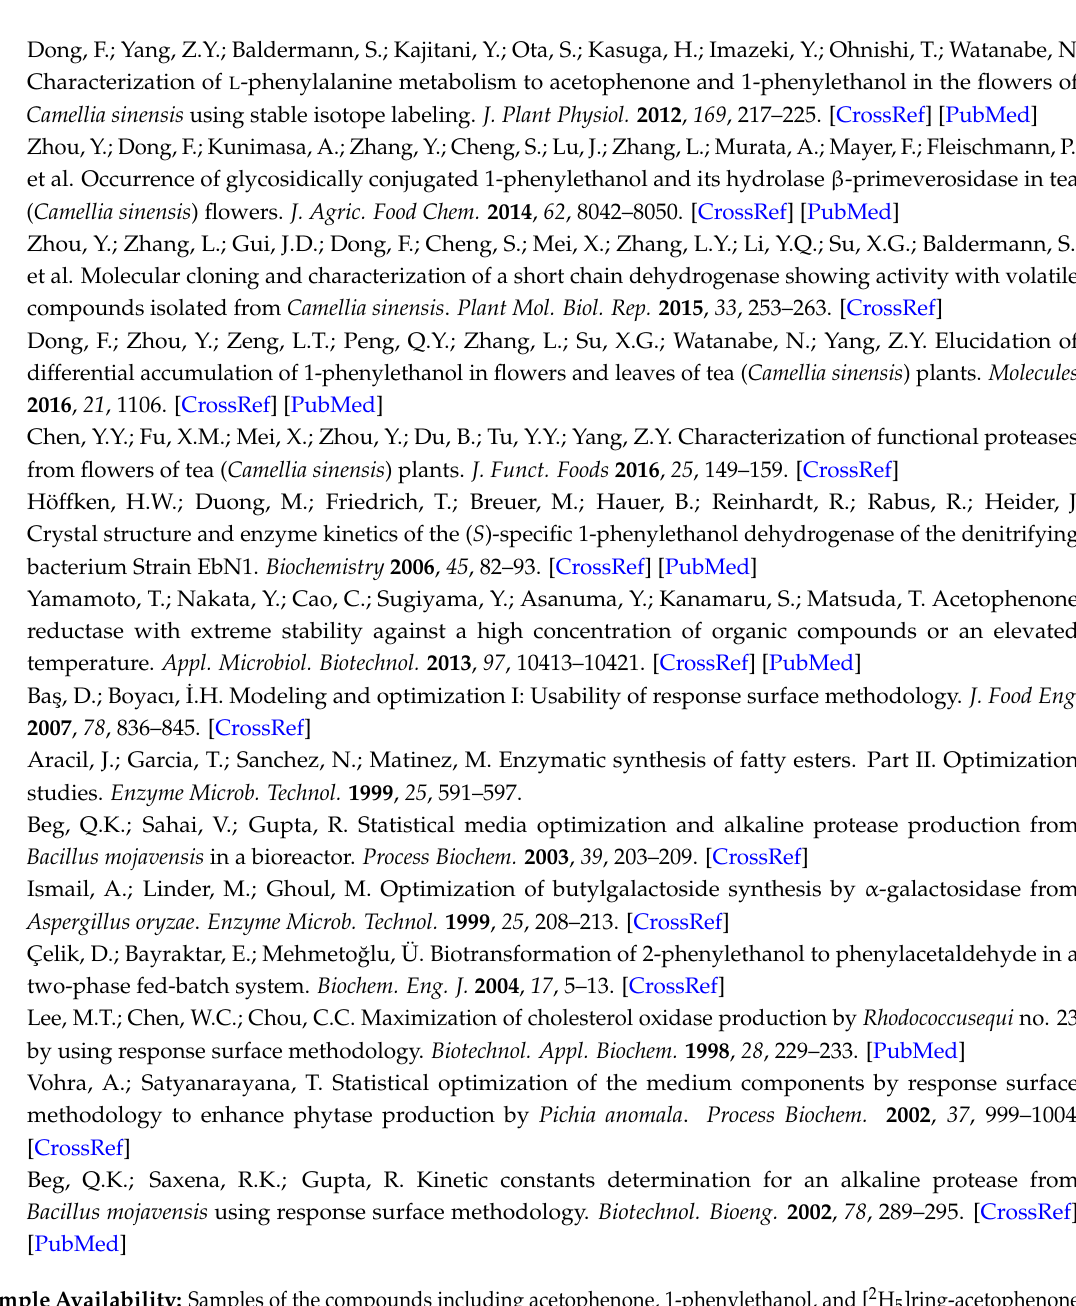
Sample Availability: Samples of the compounds including acetophenone, 1-phenylethanol, and [ 2 H 5 ]ring-acetophenone are available from the